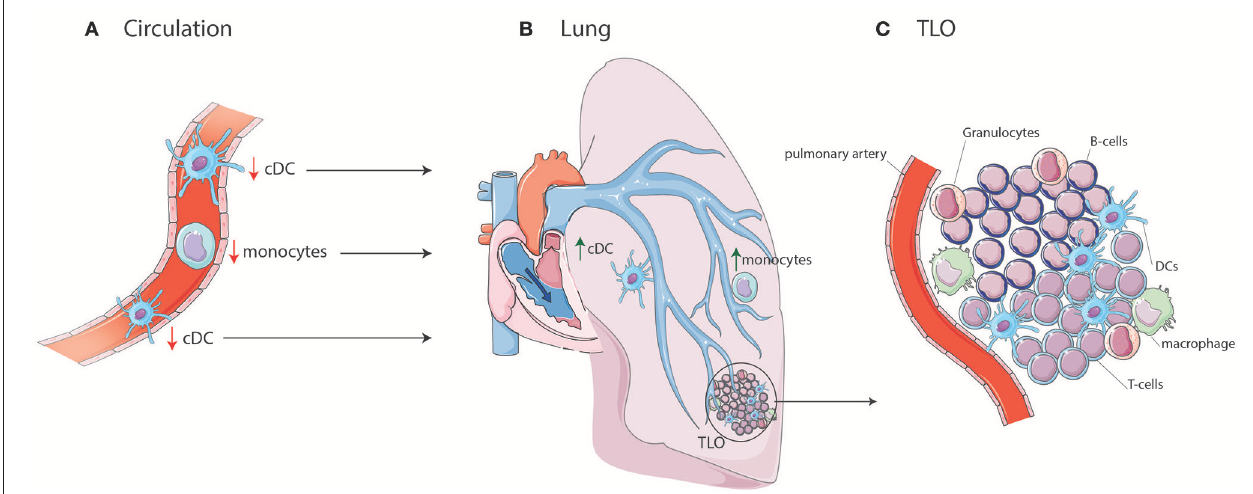
FIGURE 1 | cDC and monocyte migration toward lung TLOs. (A) cDCs and monocytes are decreased in circulation of IPAH patients due to migration to the lungs in which cDCs and monocytes are increased. (B) In the lung they can add to the development of TLOs surrounding PAs. (C) TLOs consist, besides DCs, of different immune cells such as T-cells, B-cells, macrophages, and